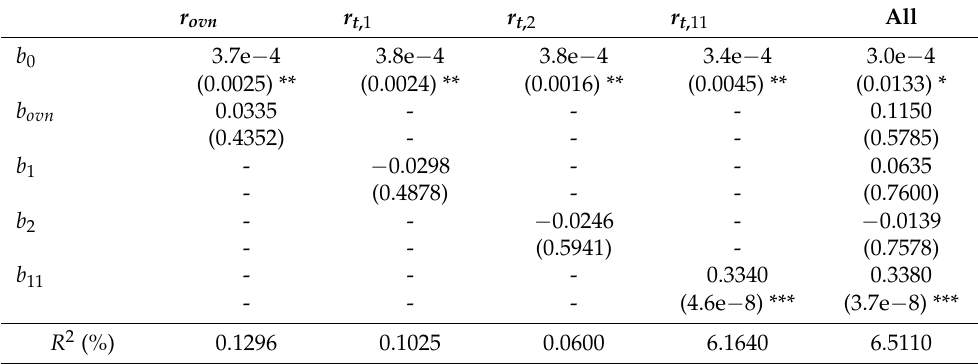
Table 6. Estimation results of Market Intraday Momentum for days with | r ovn + r 1 | < 0.1%. r